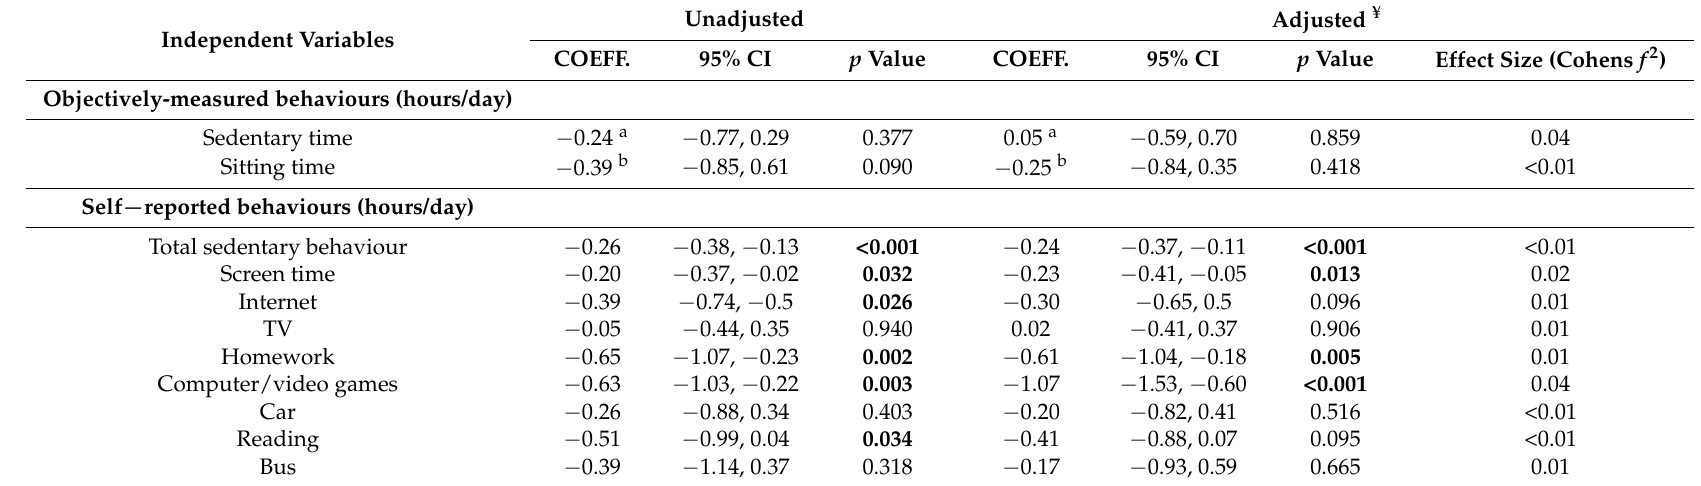
Table 3. Associations between objectively-measured daily sedentary and sitting time, self-reported sedentary behaviours outside school hours (hours/day) and social